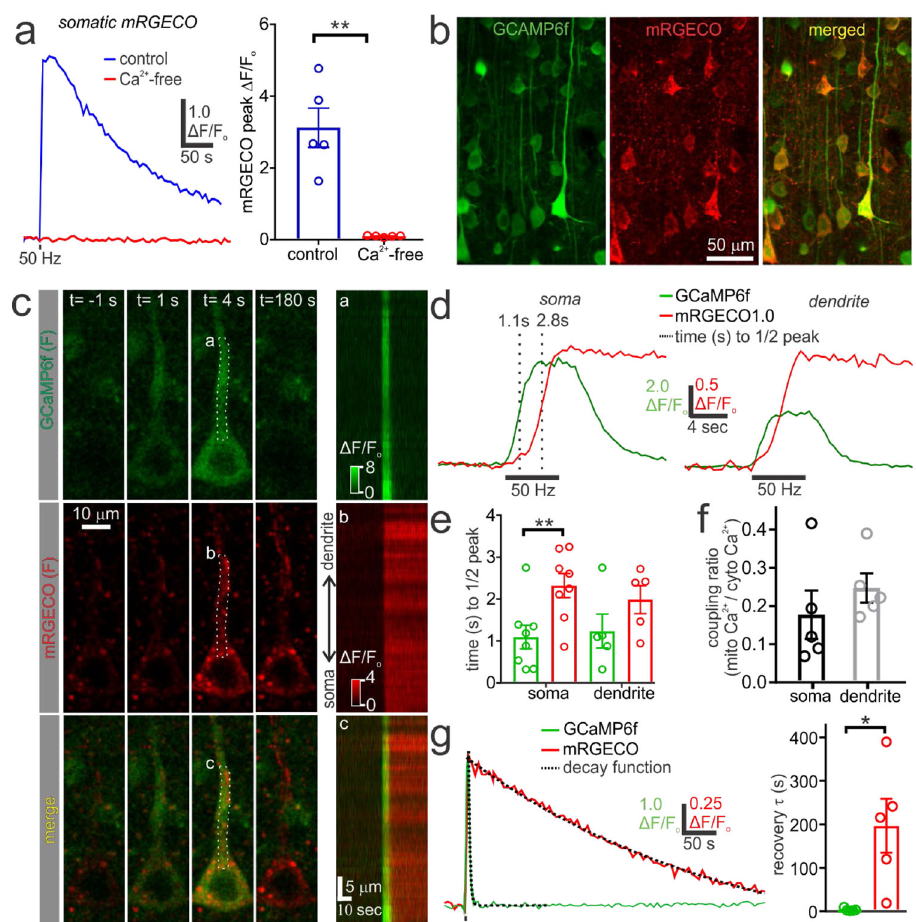
Fig. 2 Simultaneous imaging of GCaMP6f and mRGECO reveals the distinct dynamics of cytosolic and mitochondrial Ca 2 + during action potential fi ring. a Left , Somatic mRGECO fl uorescence changes from cortical pyramidal neurons during a 50-Hz, 4-sec action potential train in the presence (control) and absence of extracellular Ca 2 + (Ca 2 + -free). Right , Summary data shows a signi fi cant reduction in evoked mitochondrial Ca 2 + uptake in the absence of extracellular Ca 2 + (control: n = 5, N = 2; Ca 2 + -free: n = 5, N = 2; paired t test, p = 0.005). b Maximum intensity projection showing cortical neurons from an acute brain slice co-expressing GCaMP6f and mRGECO. c Left , Images depict GCaMP6f and mRGECO fl uorescence from a patch-clamped pyramidal neuron during the application of a 50 Hz, 4-sec action potential train. The time (t) relative to stimulus onset is depicted. Right , Kymograph showing the change in GCaMP6f and mRGECO fl uorescence along the somatodendritic axis. The ROIs used for producing the kymograph are labelled ( a – c ). d Sample trace showing that cytosolic Ca 2 + (GCaMP6f) in the soma and apical dendrite has a rapid stimulus-evoked rise time in comparison to mitochondrial Ca 2 + (mRGECO). e Stimulus-evoked changes in cytosolic Ca 2 + have a signi fi cantly shorter time to half peak than mitochondrial Ca 2 + in the soma (GCAMP: n = 8, N = 5; mRGECO: n = 8, N = 5; paired t test, p = 0.005) but not the apical dendrite (GCAMP: n = 5, N = 3; mRGECO: n = 5, N = 3; paired t test, p = 0.23). f Summary data showing the ratio of evoked changes in mitochondrial Ca 2 + and cytosolic Ca 2 + (coupling ratio) at 2-sec post- stimulus onset. The coupling ratio is low and not signi fi cantly different between the soma and apical dendrite (soma: n = 5, N = 3; dendrite: n = 5, N = 3; paired t test, p = 0.126). g Left , Sample Ca 2 + traces measured from the soma depict the rapid (seconds) recovery of post-train cytosolic Ca 2 + and the long- lasting (minutes) recovery of mitochondrial Ca 2 + to pre-stimulus baseline. The dashed lines depict the fi tted monoexponential decay functions. Right , The decay time constant ( τ ) acquired during the Ca 2 + recovery period is signi fi cantly longer in the mitochondria relative to the cytosol (GCAMP: n = 5, N = 3; mRGECO: n = 5, N = 3; paired t test, p = 0.037). Summary data presented as the mean ± SEM. * P < 0.05, ** P < 0.01. The number of cell replicates is